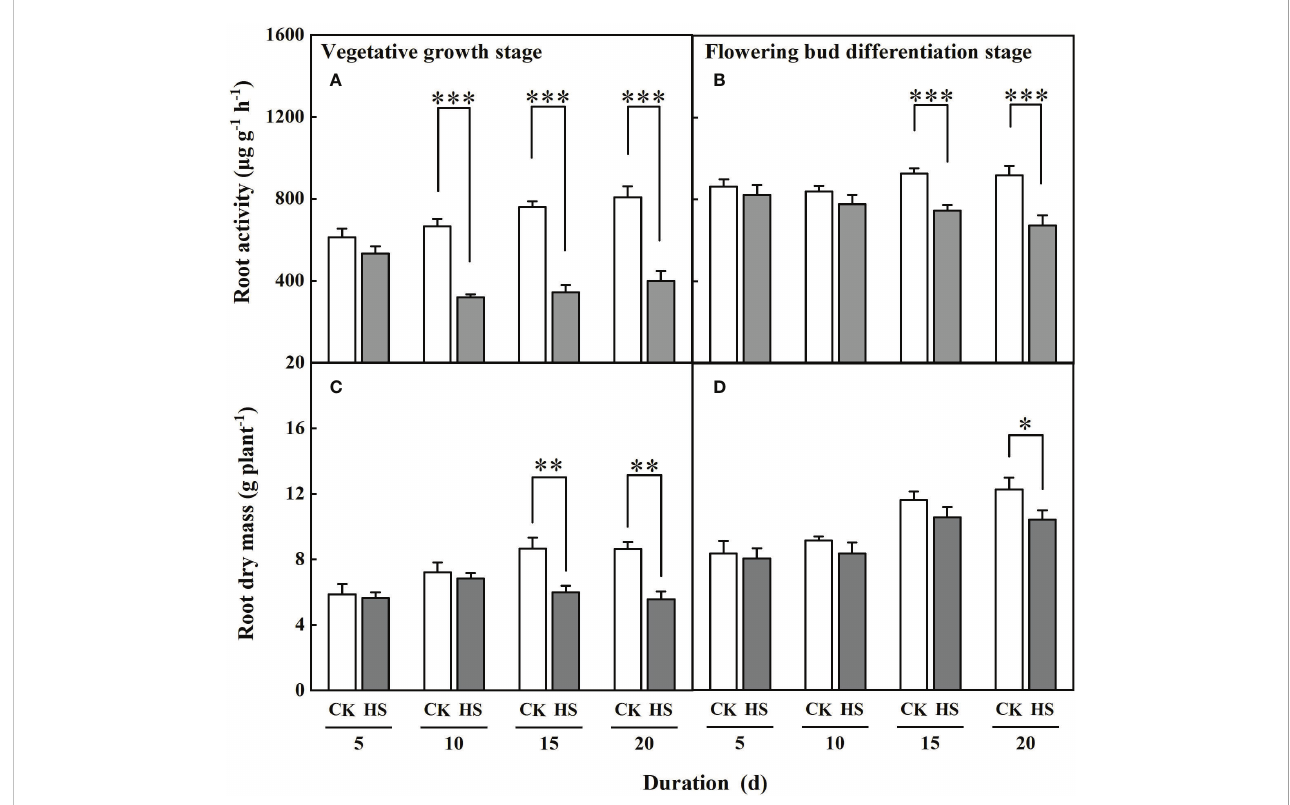
FIGURE 2 The root activity (A, B) and dry mass (C, D) of gerbera under different temperature treatments during the vegetative growth (A, C) and fl owering bud differentiation stages (B, D) . CK is the control treatment, HS is the heat stress treatment. Values are the mean ± SD (n=3). *, **, and *** represent the signi fi cant level at P <0.05, P <0.01, and P <0.001,